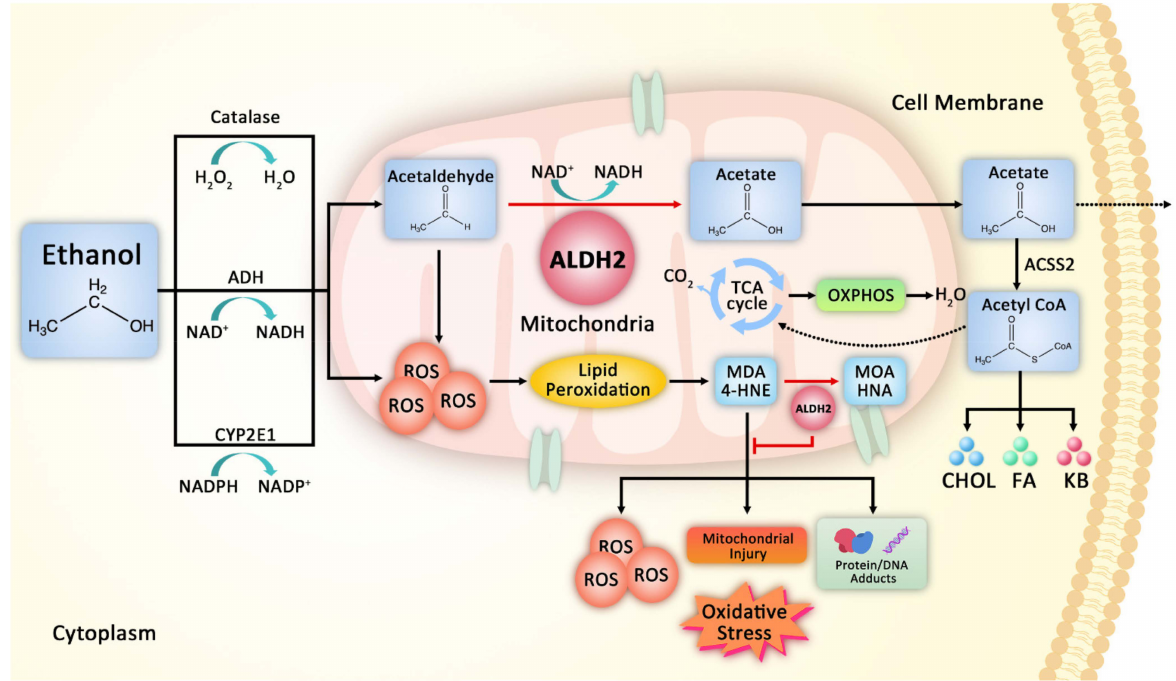
Figure 1. Pathway by which aldehyde dehydrogenase 2 (ALDH2) catalyzes aldehyde metabolism in ethanol metabolism. ALDH2 metabolizes acetaldehyde into acetate, metabolizes the malondialde- hyde (MDA) into malonic acid (MOA) or acetaldehyde, and metabolizes the 4-hydroxy-2-nonenal (4-NHE) to generate 4-hydroxy-2-nonenoic acid (NHA) to reduce the accumulation of toxic aldehydes produced during metabolism. CHOL = cholesterol; FA = fatty acids; KB = ketone